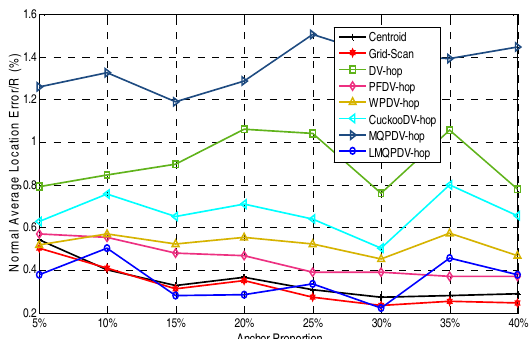
Figure 14. Communication range 250 WSN#2.